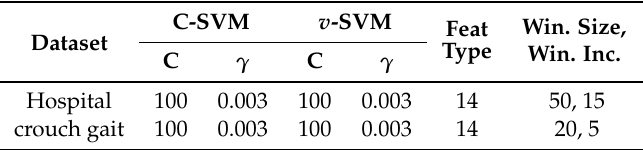
Table 3. Optimal parameters for all classifiers.